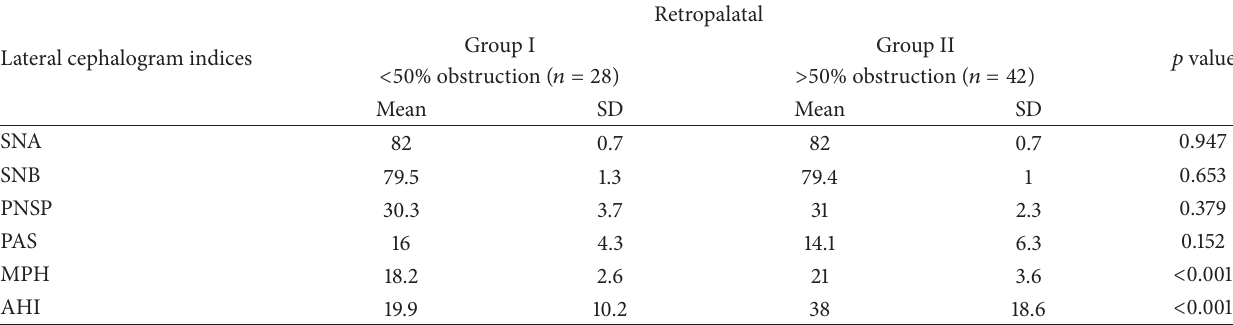
Table 2: Association of retropalatal region on flexible nasopharyngolaryngoscopy with lateral cephalometric variables.